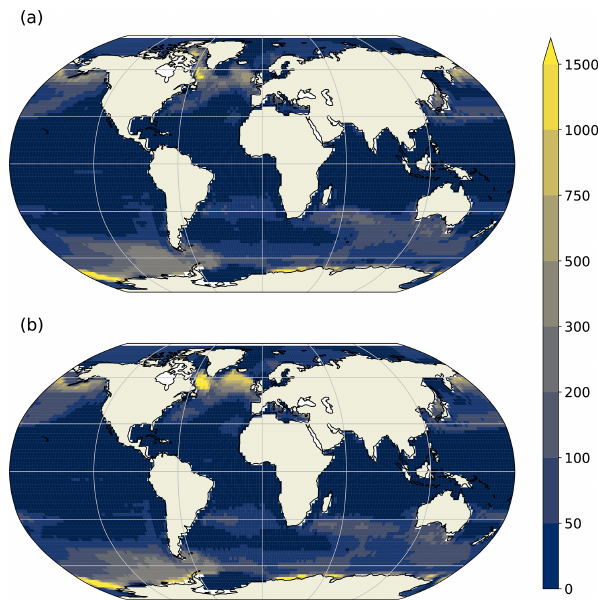
Figure 11. Winter mixed layer depths (m) averaged over the years 2000–2025 of (a) the L35 integration and (b) the L20 inte- gration. The Northern (Southern) Hemisphere shows mixed layer depths for the month of March (September). The mixed layer depth is defined as the depth at which a density difference from the top layer of 0.03kgm − 3